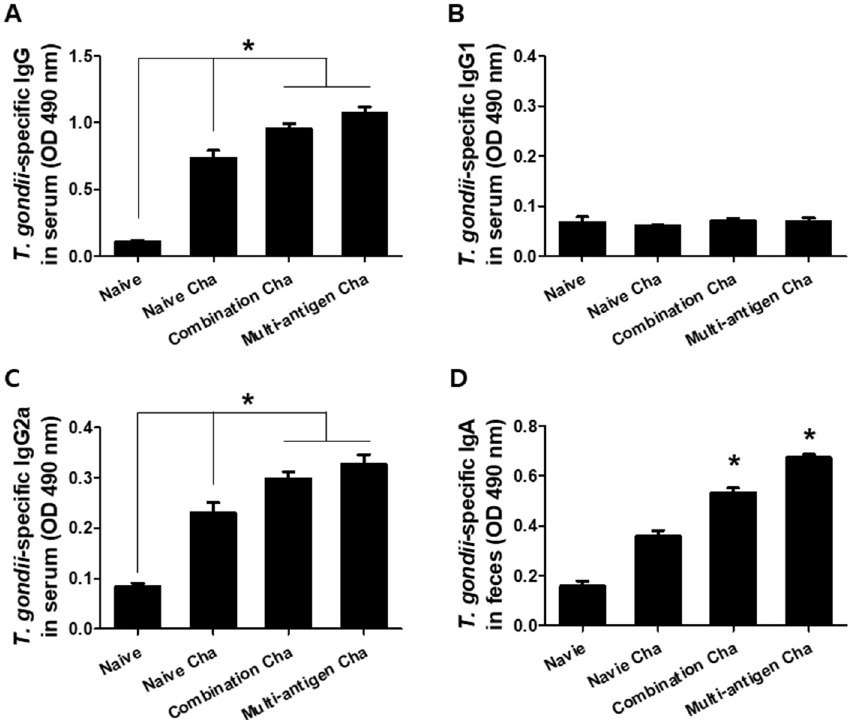
Fig 2. T . gondii -specific antibody responses. T . gondii -specific IgG, IgG1 and IgG2a were determined in mice sera after challenge infection. Higher levels of IgG and IgG2a were found in multi-antigen VLPs (Multi-antigen Cha) or combination VLPs (Combination Cha) immunized mice compared to na ï ve challenged mice (Na ï ve Cha) (A and C, � P < 0.01). T . gondii -specific IgA antibody response was determined from mice feces (D). VLPs vaccination showed higher level of IgA response in both Multi-antigen Cha and Combination Cha compared to Na ï ve Cha (D, � P < 0.01).